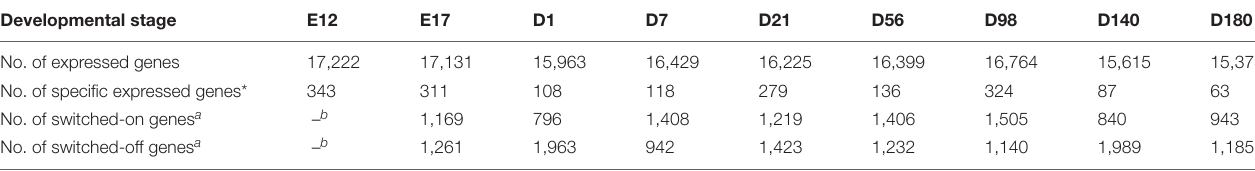
FIGURE 1 | The phenotypes of body weight (BW), liver weight, and abdominal fat weekly gain (AFWG) during development. (A) The RNA-sequenced chicken BW fitted curve. (B) The sequenced chicken liver weight fitted curve. (C) The AFWG in different periods. (D – G) The Oil-Red-O-stained sections of the liver in E12, E17, D1, and D21, respectively. Red colors are the stained lipid or adipocytes. TABLE 1 | The number of expressed, specific expressed, and switched-on/off